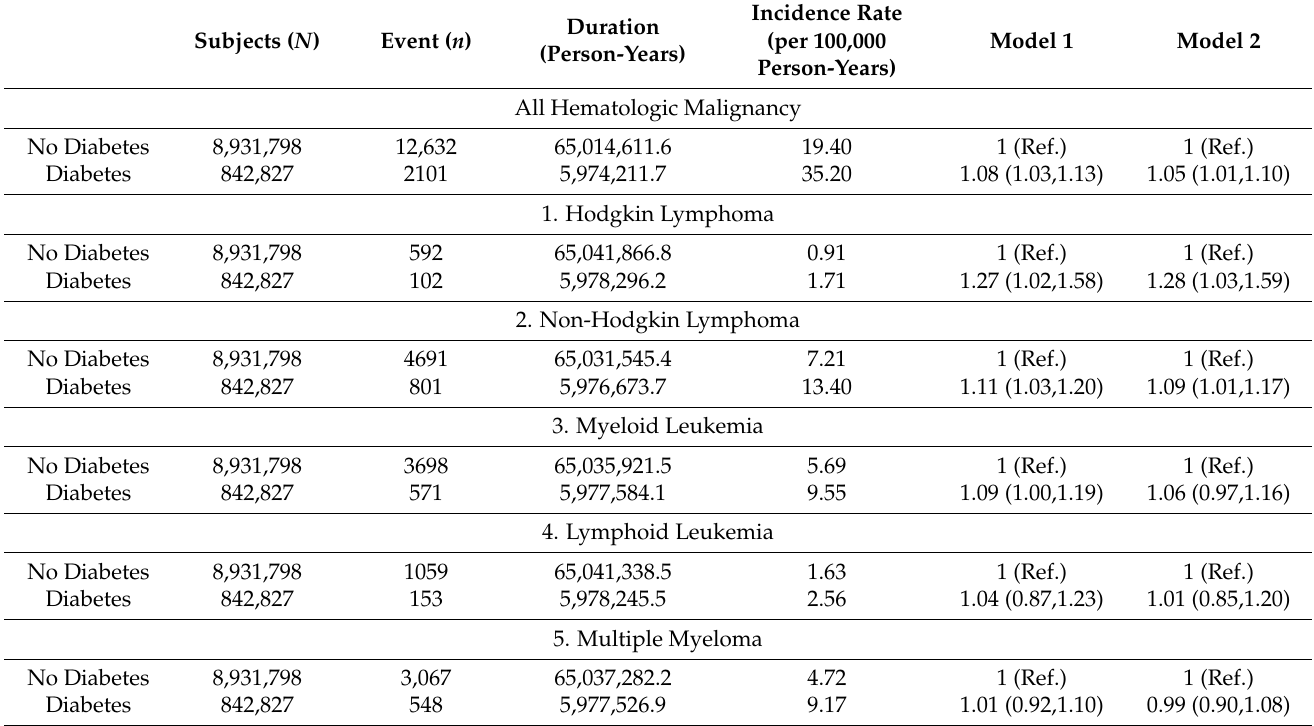
Table 2. The risk of hematologic malignancies among the participants with